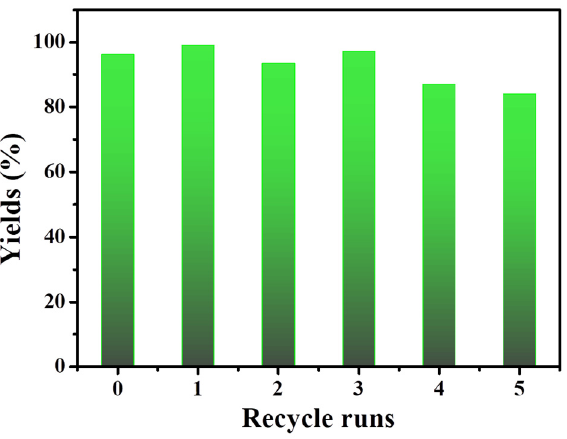
Figure 6. Recycle test of the catalyst POP-PBC in the cycloaddition reaction of the CO 2 with epichlo- rohydrin.